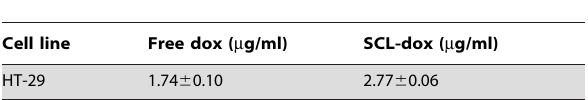
Table 1. Mean IC 50 values ( m g/ml of doxorubicin) for treatment with free DOX and SCL-DOX.